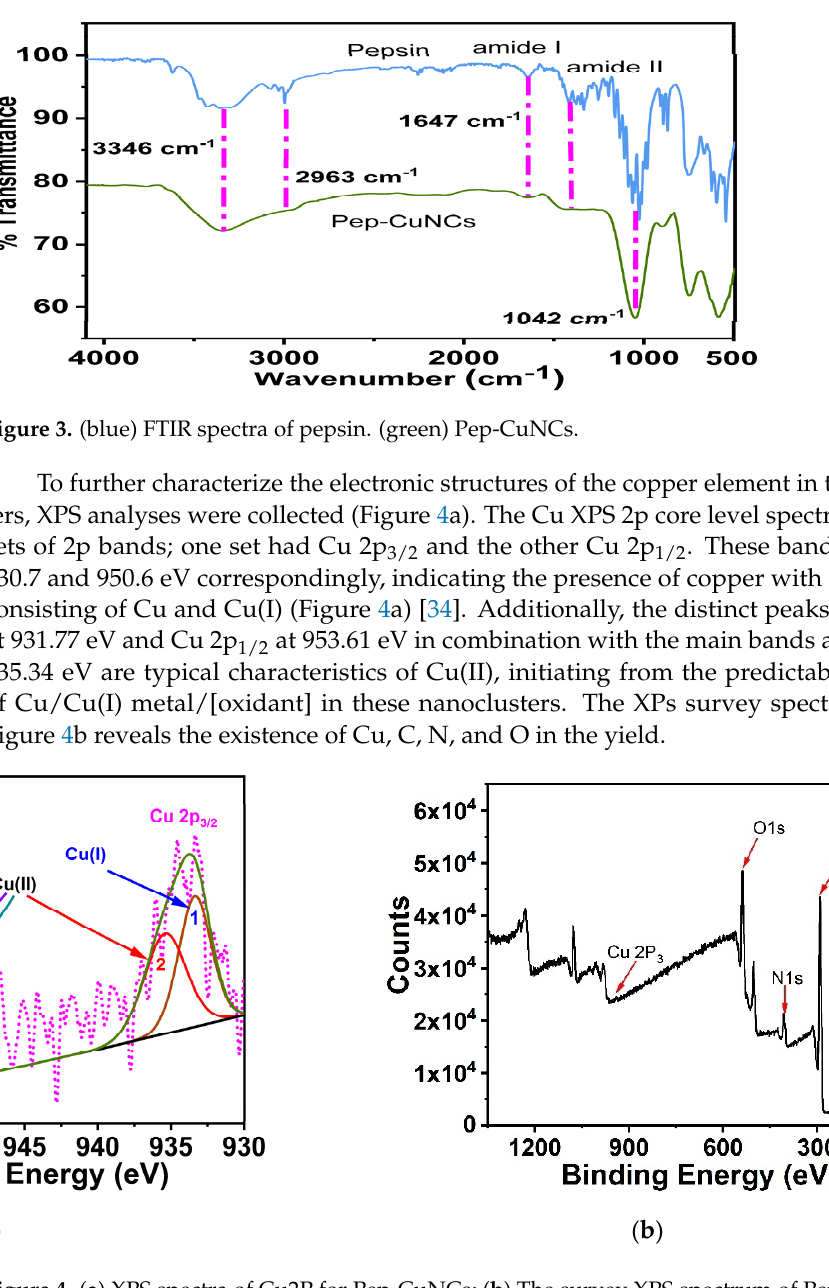
( d ) Figure 2. ( a,b ) TEM images, ( c ) DLS, and ( d ) SD histogram of the as-prepared Pep-CuNCs. To detect the active chemical groups that exist in the Pep-CuNCs, IR spectra were